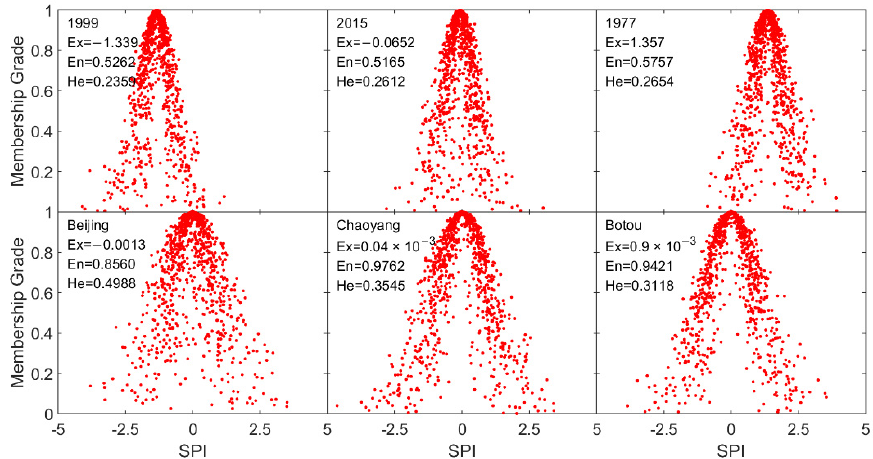
Figure 8. SPI membership cloud map of typical years and stations.